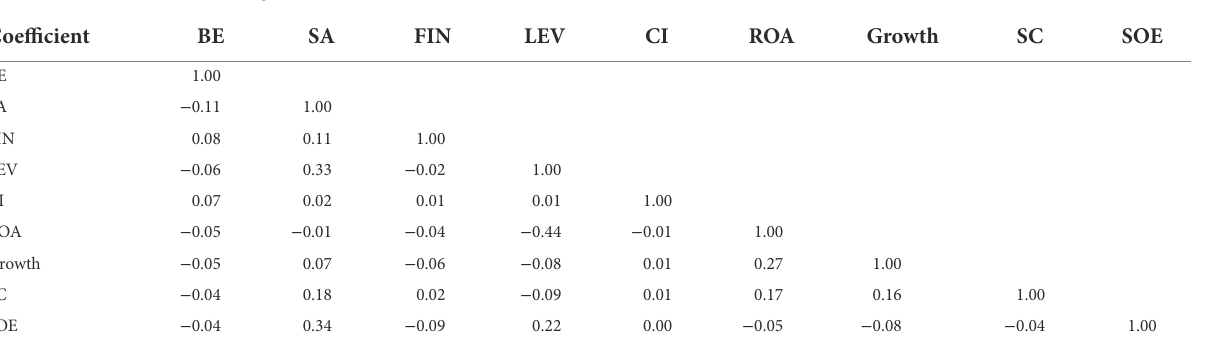
TABLE 2 Pearson correlation